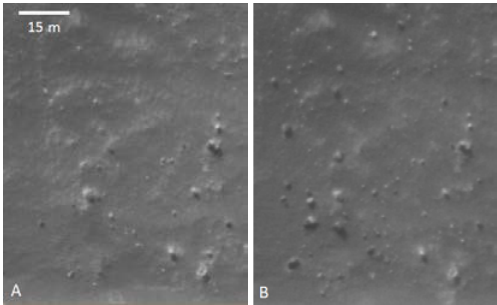
Figure 3. Test area with 4 years difference